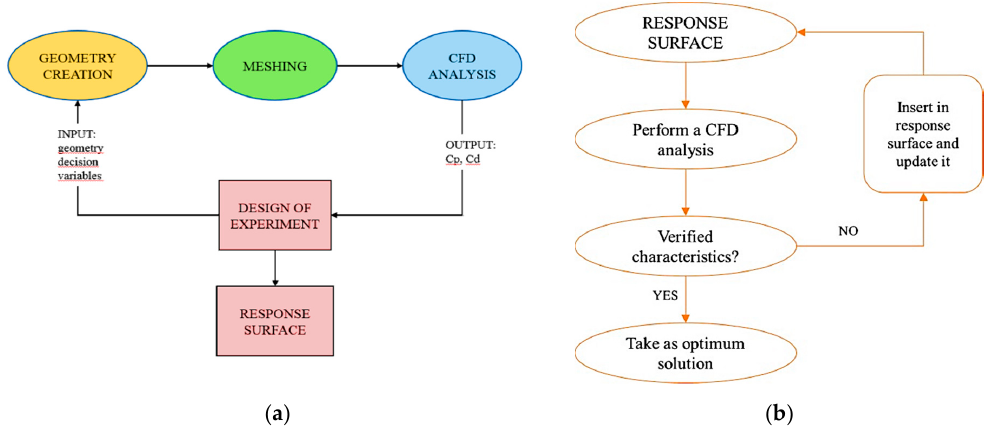
Figure 6. Optimization procedure: ( a ) general loop; ( b ) response surface update workflow.